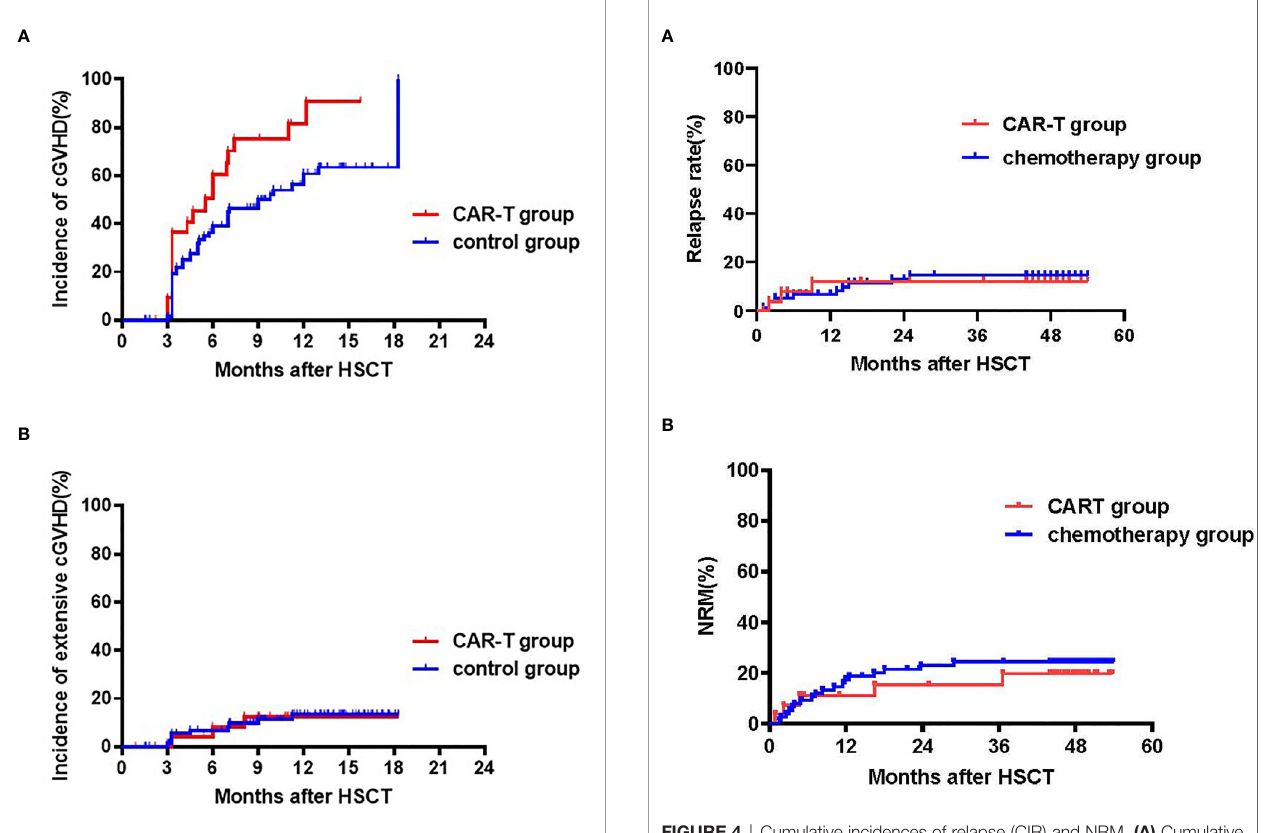
FIGURE 3 | Cumulative incidences of chronic and extensive chronic GVHD. (A) Cumulative incidences of chronic GVHD: CAR T-cell group: 73.3% (95% CI: 71.3, 75.3%) vs. chemotherapy group: 55.0% (95% CI: 54.2, 55.8%); p=0.107. (B) Cumulative incidences of extensive chronic GVHD: CAR T-cell group: 11.1% (95% CI:10.3, 11.9%) vs. the chemotherapy group: 11.9% (95% CI: 11.7, 12.1%); p=0.964.